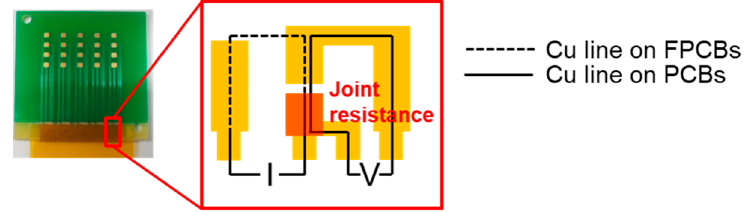
Figure 13. Electrical design for a four-point-probe measurement.